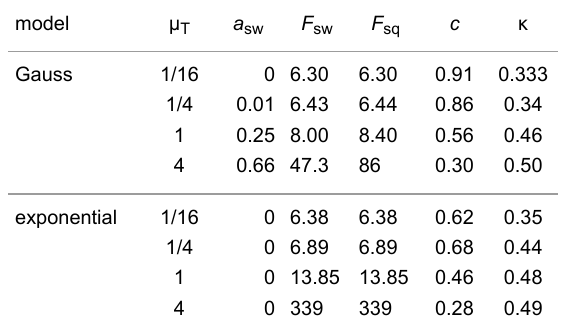
Table 1: Results of fits to the data shown in Figure 16. The last digit may not be significant. model